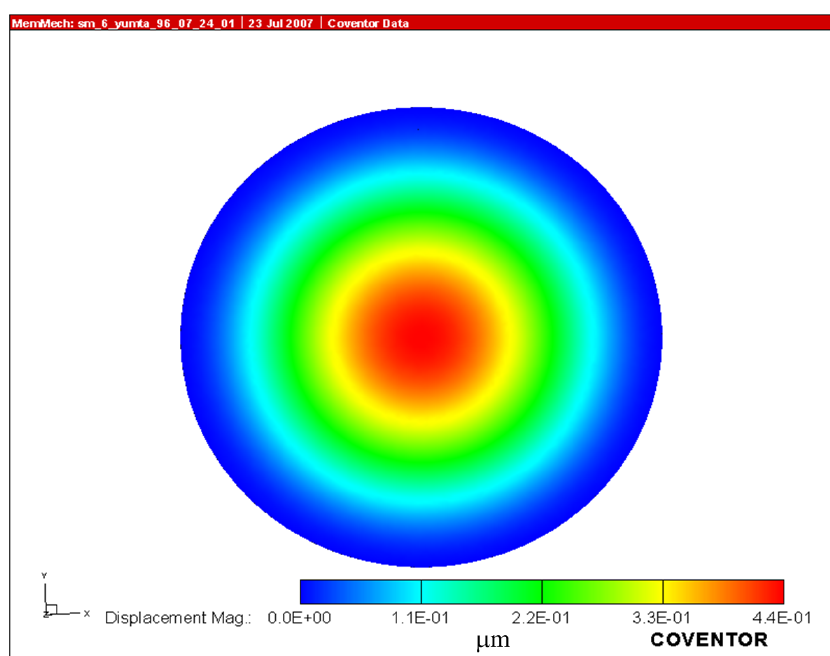
Figure 4. Displacement of the